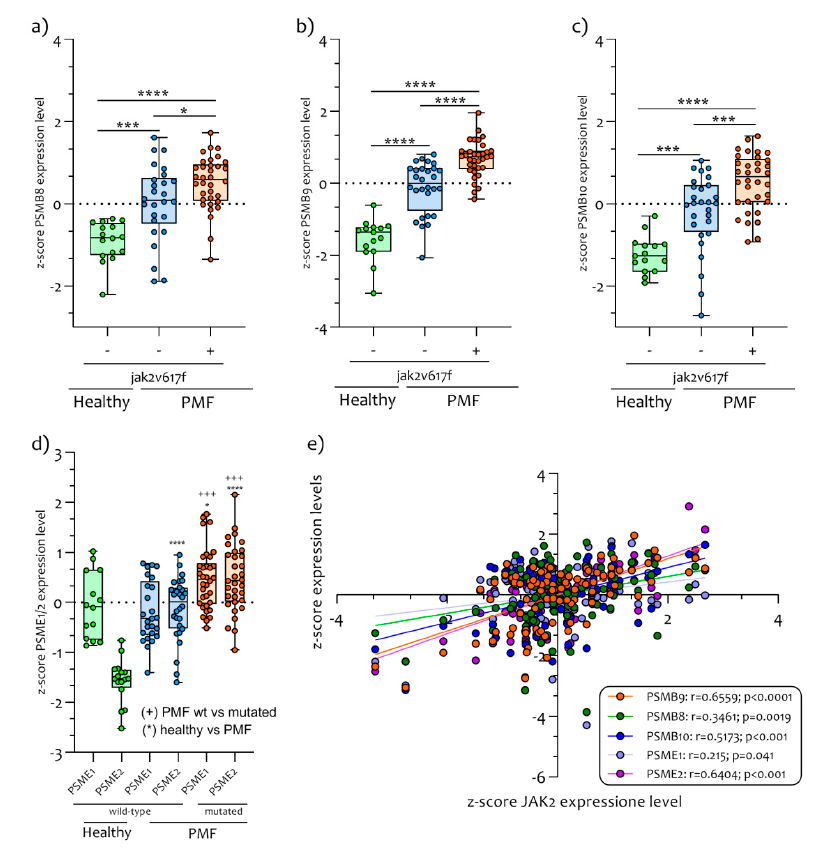
Figure 2. IPs genes expression in PB CD34 + Cells of JAK2 V617F mutated/wild-type PMF patients and healthy control subjects. The genes belonging to the IPs family are PSMB8 ( a ), PSMB9 ( b ), PSMB10 ( c ) and PSME1/2 ( d ). The patients affected by primary myelofibrosis express significant upregulated levels of IPs compared to healthy controls. In addition, the PMF patients mutated for JAK2 V617F express significant upregulated levels of IPs genes compared to wild-type patients. The JAK2 gene expression levels in PB CD34 + cells of PMF patients were significantly correlated with IPs genes expression. Data are expressed as z-score intensity expression levels and presented as vertical scatter dot plots. p values < 0.05 were considered to be statistically significant (* p < 0.05; *** p < 0.0005; **** p <